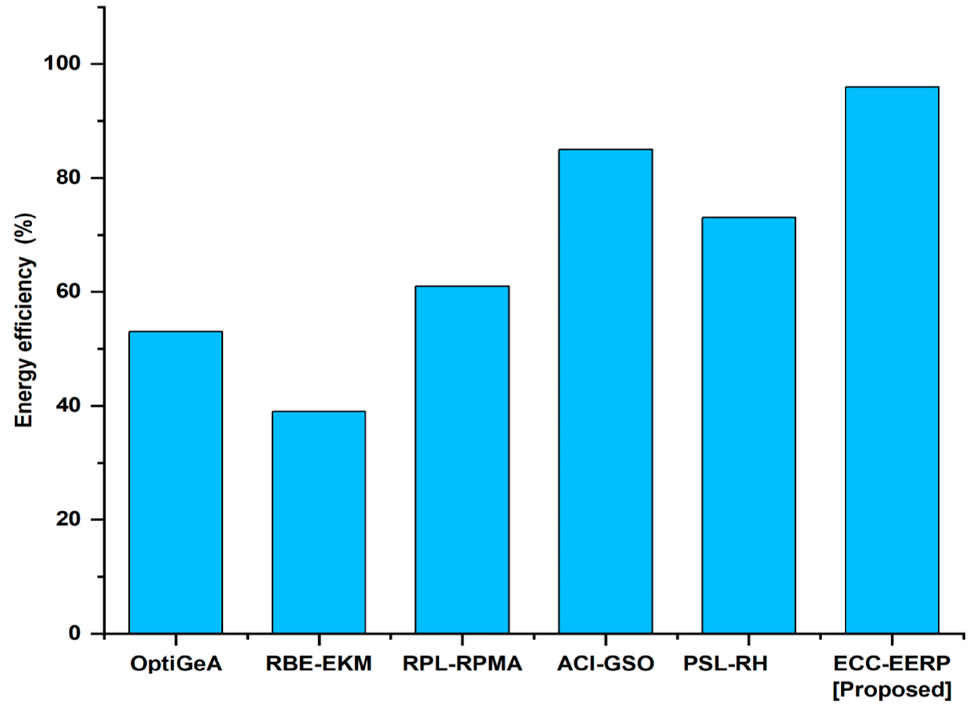
Figure 6. Energy efficiency of the proposed and existing methods [41–45]. Table 5. Energy efficiency of the proposed and existing methods .